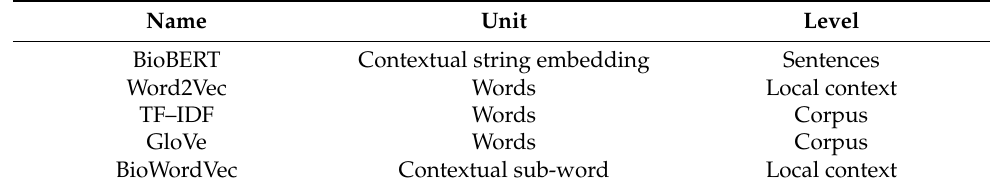
Table 2. The vector representation models and their characteristics. Name Unit Level BioBERT Contextual string embedding Sentences Word2Vec Words Local context TF–IDF Words Corpus GloVe Words Corpus BioWordVec Contextual